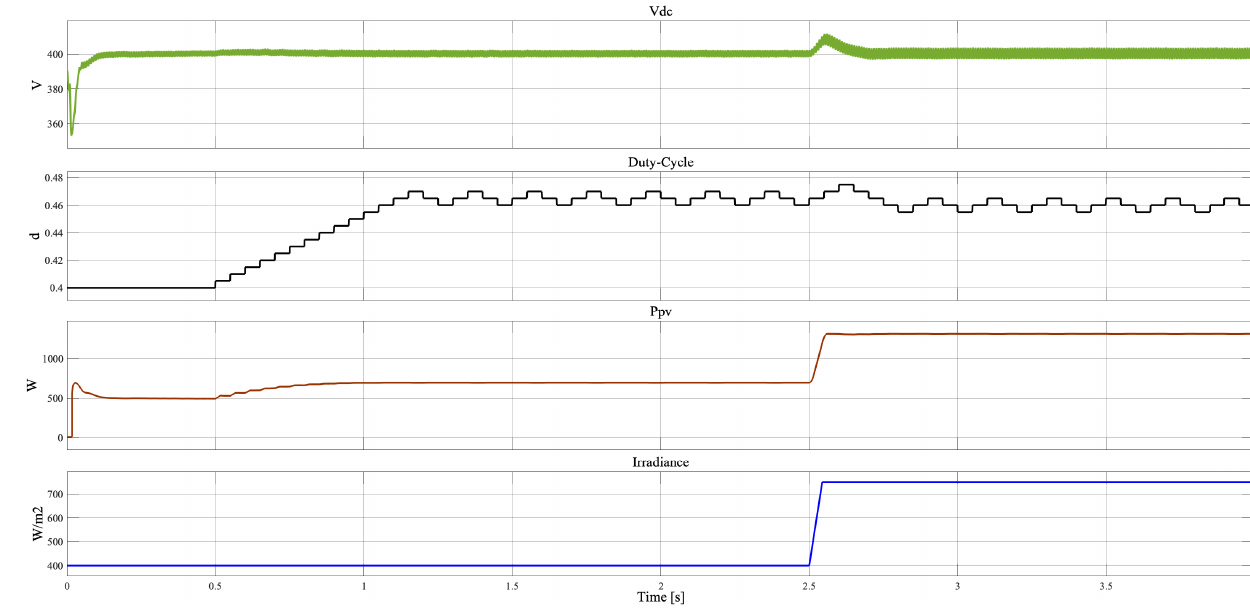
Figure 8. Output voltage of boost converter, duty-cycle, PV power, and